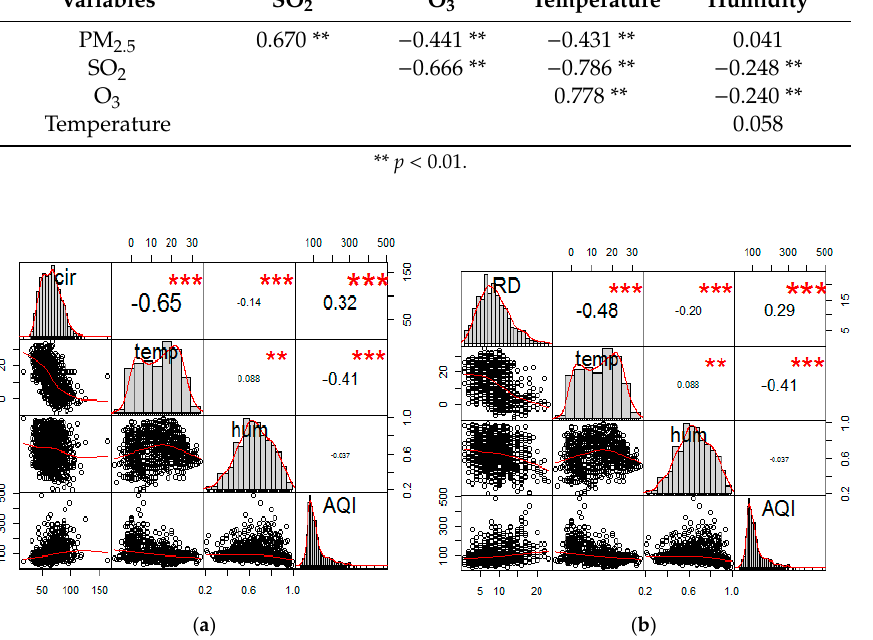
Figure 1. Scatterplot matrices of correlation between AQI, temperature, relative humidity, and both mortality (circulatory and respiratory) in Xi’an (2014–2016). ( a ) Circulatory mortality. ( b ) Respiratory mortality.